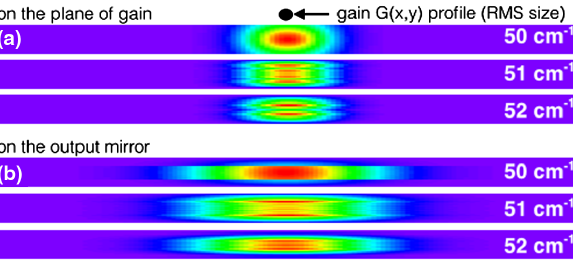
FIG. 28. Laser profile amplitude in the waveguide ( 200 × 1 cm): (a) on the plane of gain and (b) on the output mirror, at various